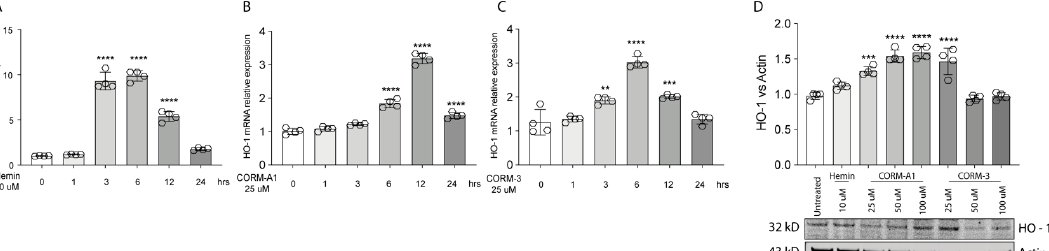
Figure 1. Hemin, CORM-A1, and CORM-3 trigger HO-1 accumulation. ( A ) Hemin (10 μ M) increases HO-1 mRNA levels. qPCR analysis showing the increase in HO-1 mRNA levels upon hemin supplementation 3, 6, and 12 h post-treatment. ( B ) CORM-A1 (25 μ M) induces HO-1 expression. HO-1 increases its expression 6, 12, and 24 h post-treatment. ( C ) CORM-3 (25 μ M) leads to HO-1